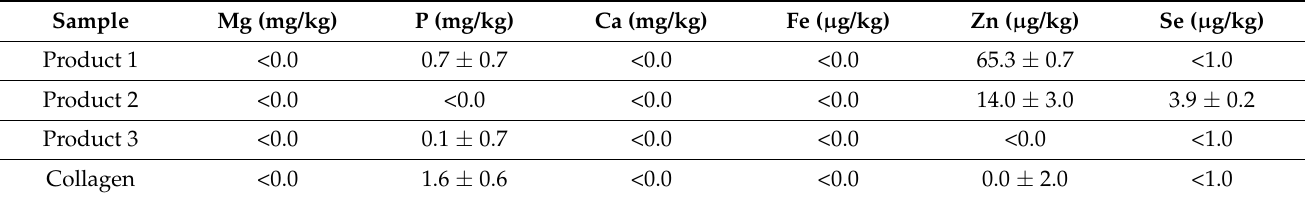
Table 3. Mineral content of the bioavailable fraction of product 1, product 2, product 3 and collagen.